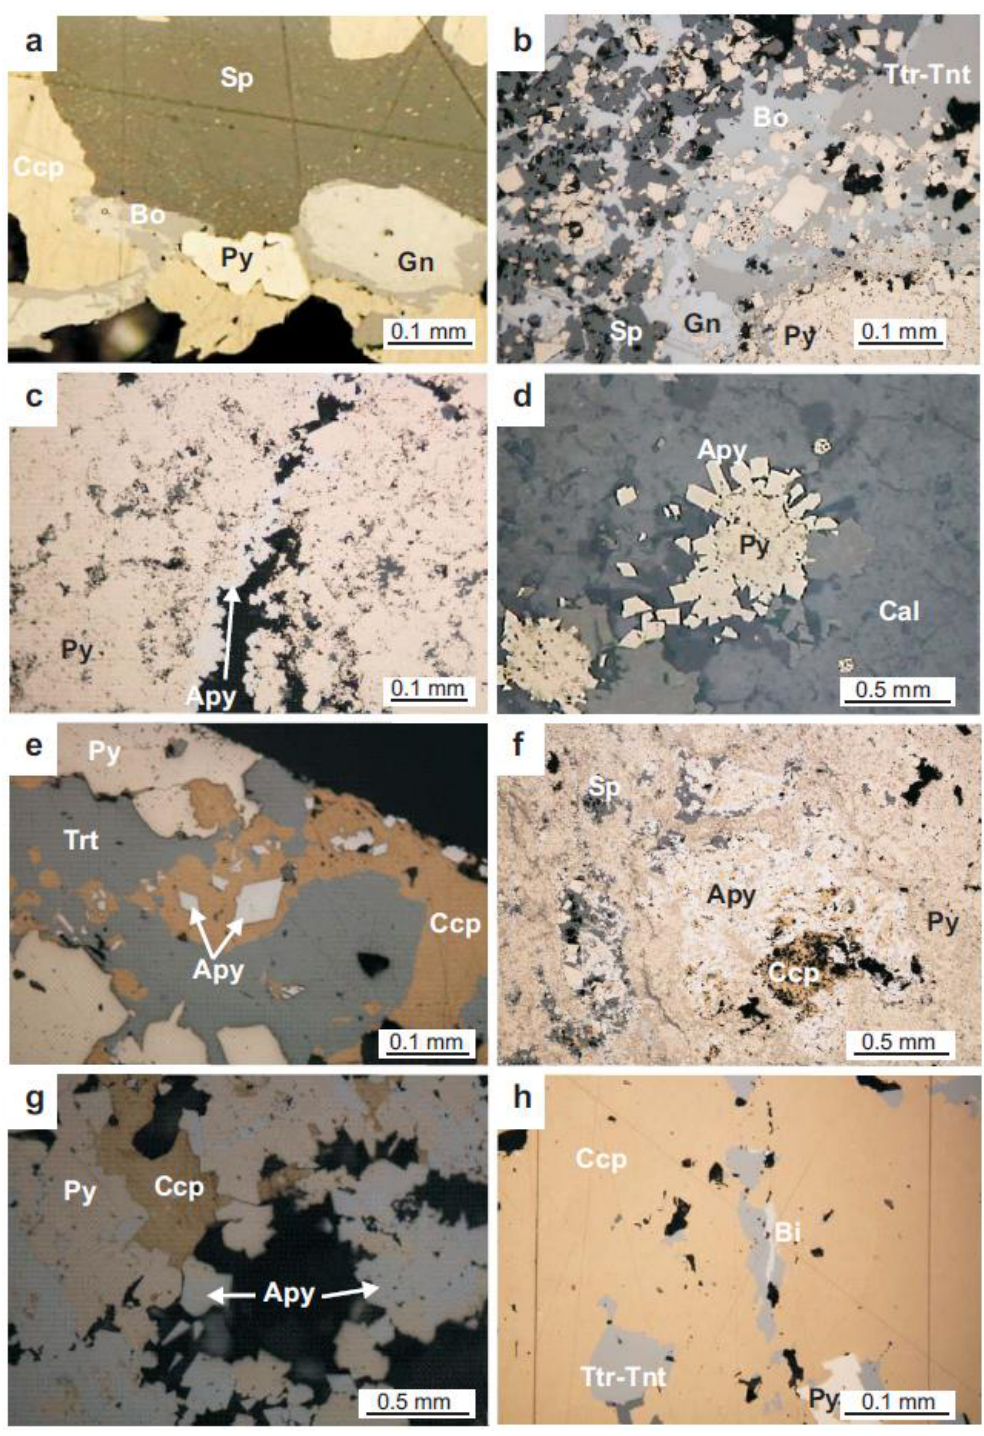
Figure 8. Optical microscope images of polymetallic mineralizations with As–Sb from several massive sulfide deposits of the IPB. ( a , b ) Late Cu–Pb–As–Sb sulfosalts, including boulangerite (Bo) and tetrahedrite–tennantite (Ttr–Tnt) replacing suitable sulfides; ( c ) late arsenopyrite (Apy) filling open spaces in pyrite aggregates; ( d ) fine grained pyrite overgrown by idiomorphic late arsenopyrite; ( e ) interstitial chalcopyrite (Cpp) in pyrite (Py) partially replaced by tetrahedrite–tennantite. Idiomorphic arsenopyrite crystals are also present; ( f ) arsenopyrite replacing pyrite and overgrowing former sulfides; ( g ) late arsenopyrite filling open space in a pyrite aggregates; ( h ) veinlet of bismuthine (Bi) associated with tetrahedrite–tennantite in chalcopyrite ore. Frailes deposit ( a , b , d ) and Magdalena deposit ( c , e , g , h ).